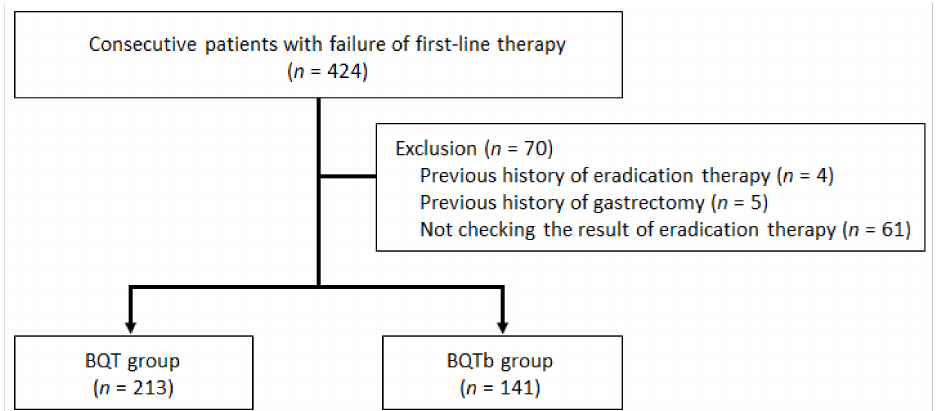
Figure 1. Flow chart of the study. BQT: conventional bismuth quadruple therapy; BQTb: twice a day